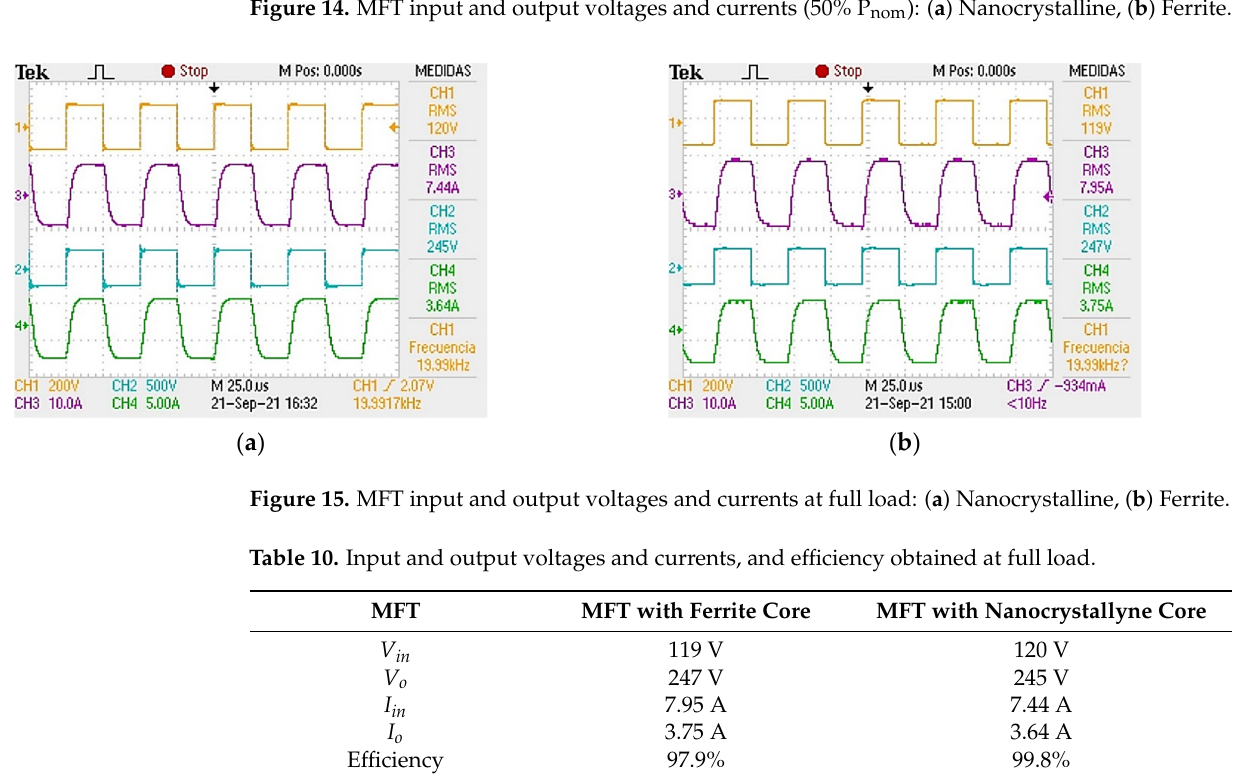
Table 11. Efficiencies obtained at 50%, 25%, and 6% of the nominal power.